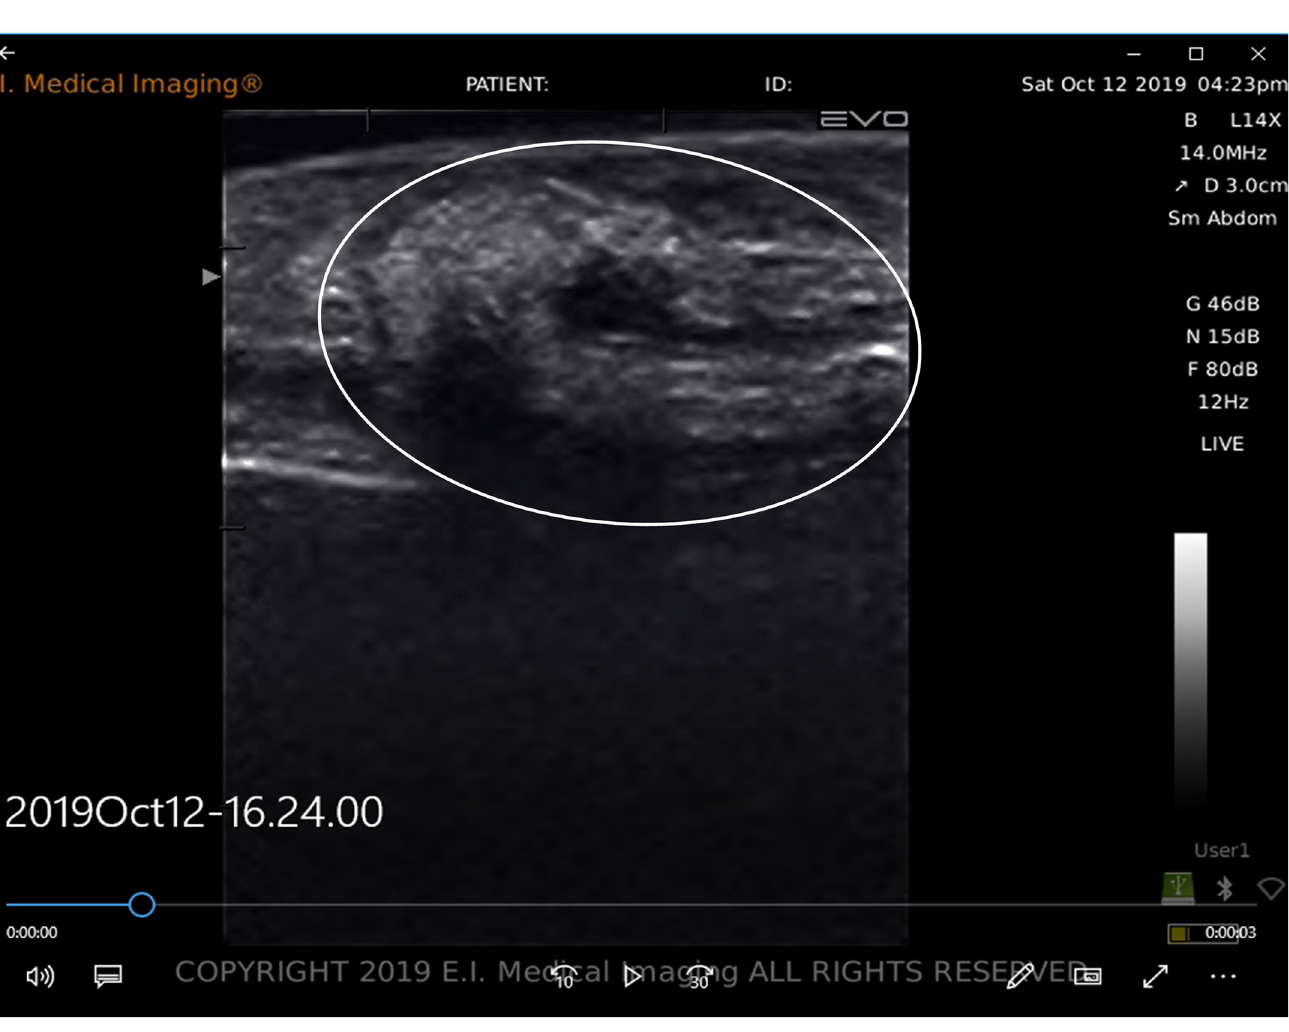
Fig 2. Ultrasound image showing the stomach as a U-shaped object